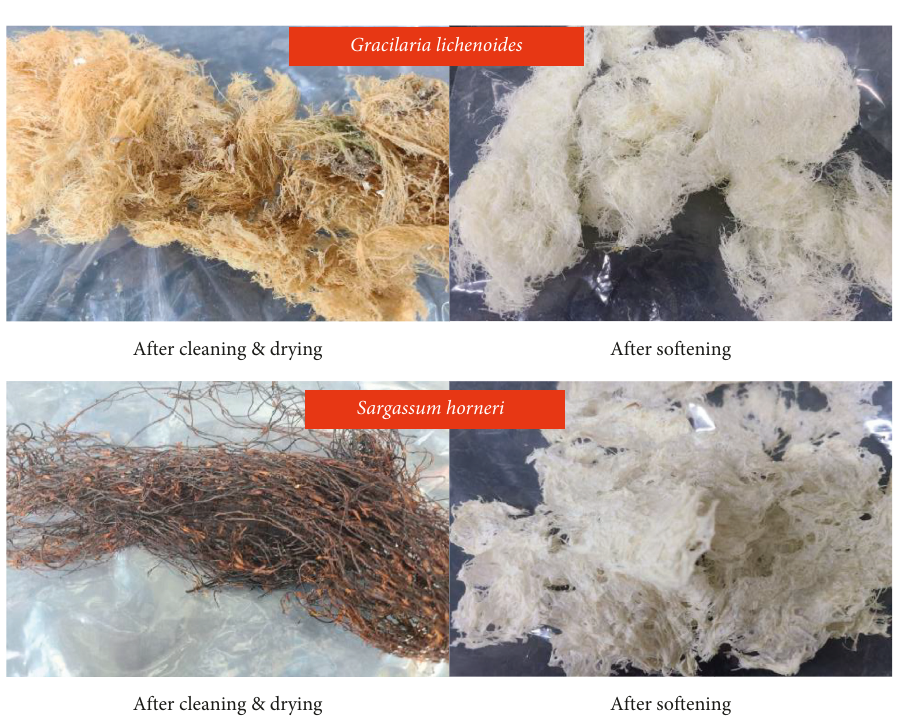
Figure 2: Appearance of raw materials ( Gracilarialichenoides and Sargassumhorneri ).